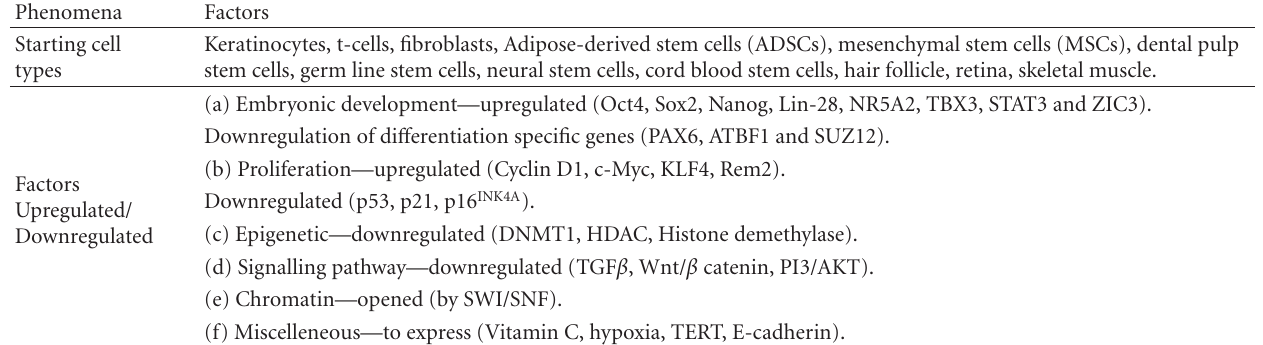
Table 1: Nuclear reprogramming: various cell types that can be reprogrammed are shown in Table 1. During reprogramming several cell markers for pluripotency or di ff erentiation are upregulated or